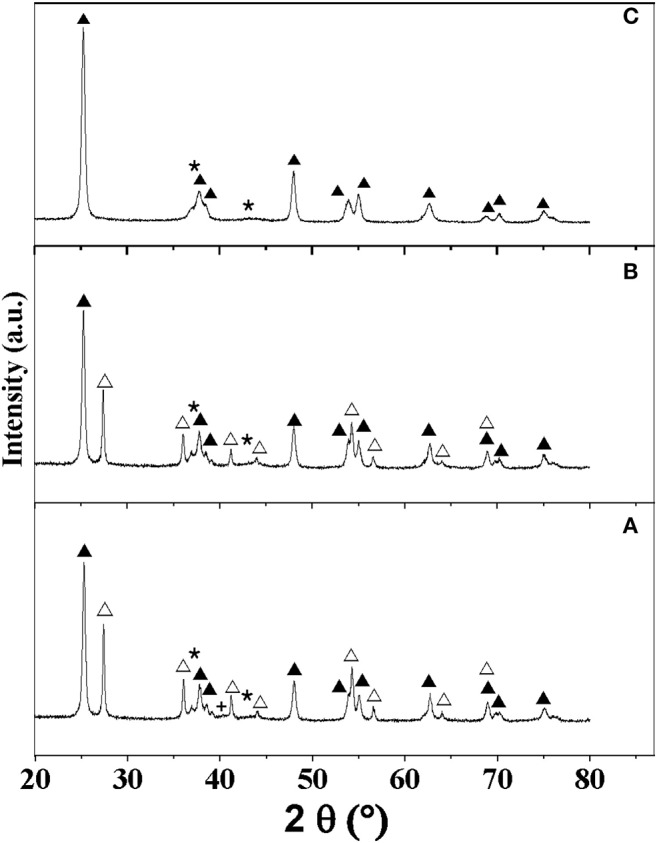
XRD patterns of the catalysts: (A) MoNA/TiO2-P, (B) MoNB/TiO2-P, and (C) MoNB/TiO2-D. Assignment of peaks: (▴) anatase, (△) rutile, (⋆) MoN, and (+) Mo.